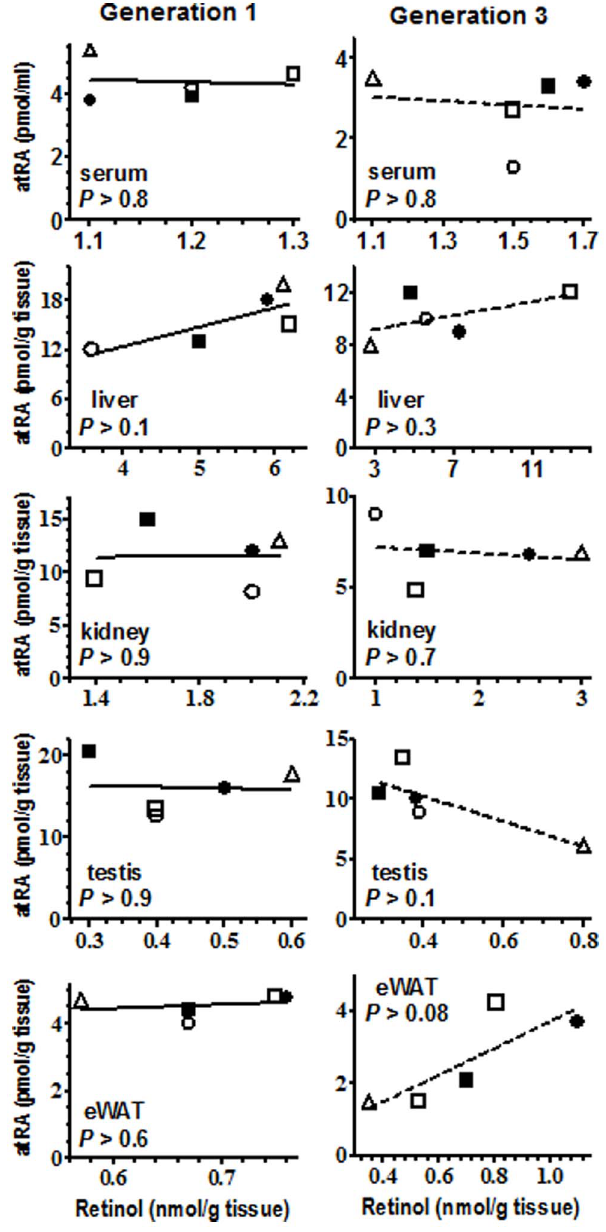
Figure 2. Relationships between retinol and atRA. Retinol (x-axis) and atRA (y-axis) values for serum and tissues from first generation (left column) and third generation (right column) fed a VAS (eWAT, epididymal white adipose tissue): % , C3H; D , AKR; & , 129; BALB. Linear regression analysis for each tissue and generation verified that none of the slopes differed significantly from